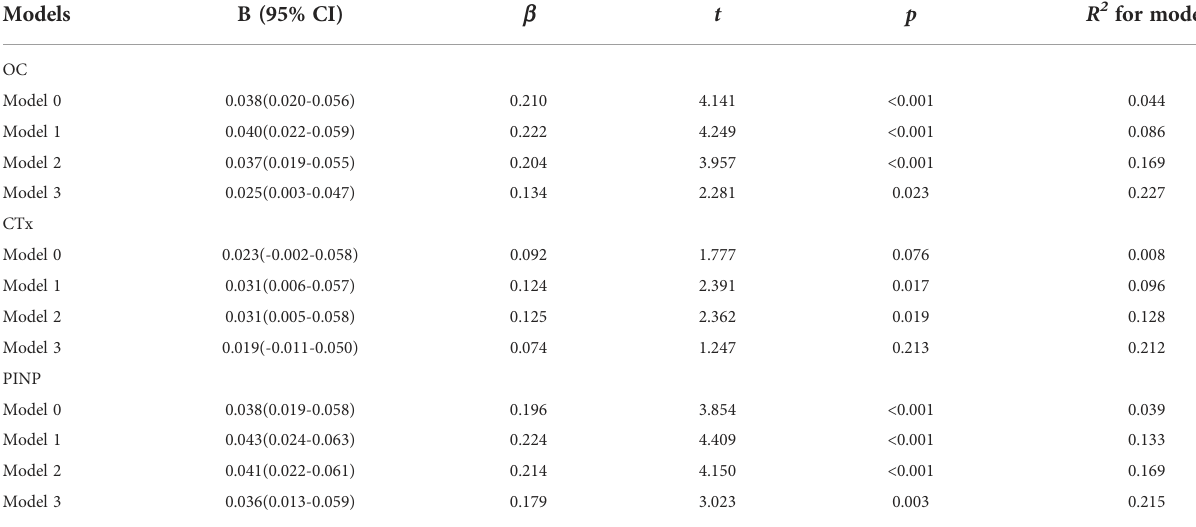
TABLE 3 Independent associations of serum sodium level with BTMs levels via multivariate linear regression analysis.